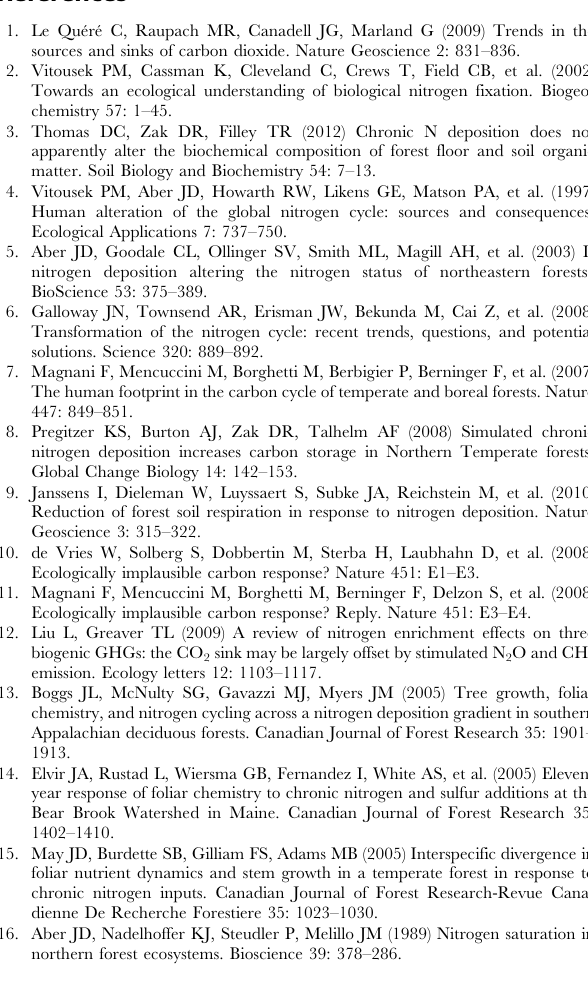
Figure S1 Diameter at breast height (DBH) and height of trees with nitrogen (N) fertilization in 2010 (black) and 2012 (gray). (TIF) Figure S2 Fine root biomass among different nitrogen (N) fertilization gradients in 2012. Significant differences among N treatments are indicated by different letters. (TIF) Figure S3 Effects of nitrogen (N) addition on foliar N concentrations of herbaceous layer plants. Significant differences among N treatments are indicated by different letters. (TIF) Figure S4 Soil pH in control and nitrogen (N) treat- ments plots after 3 years fertilization. Significant differ- ences among N treatments are indicated by different letters.